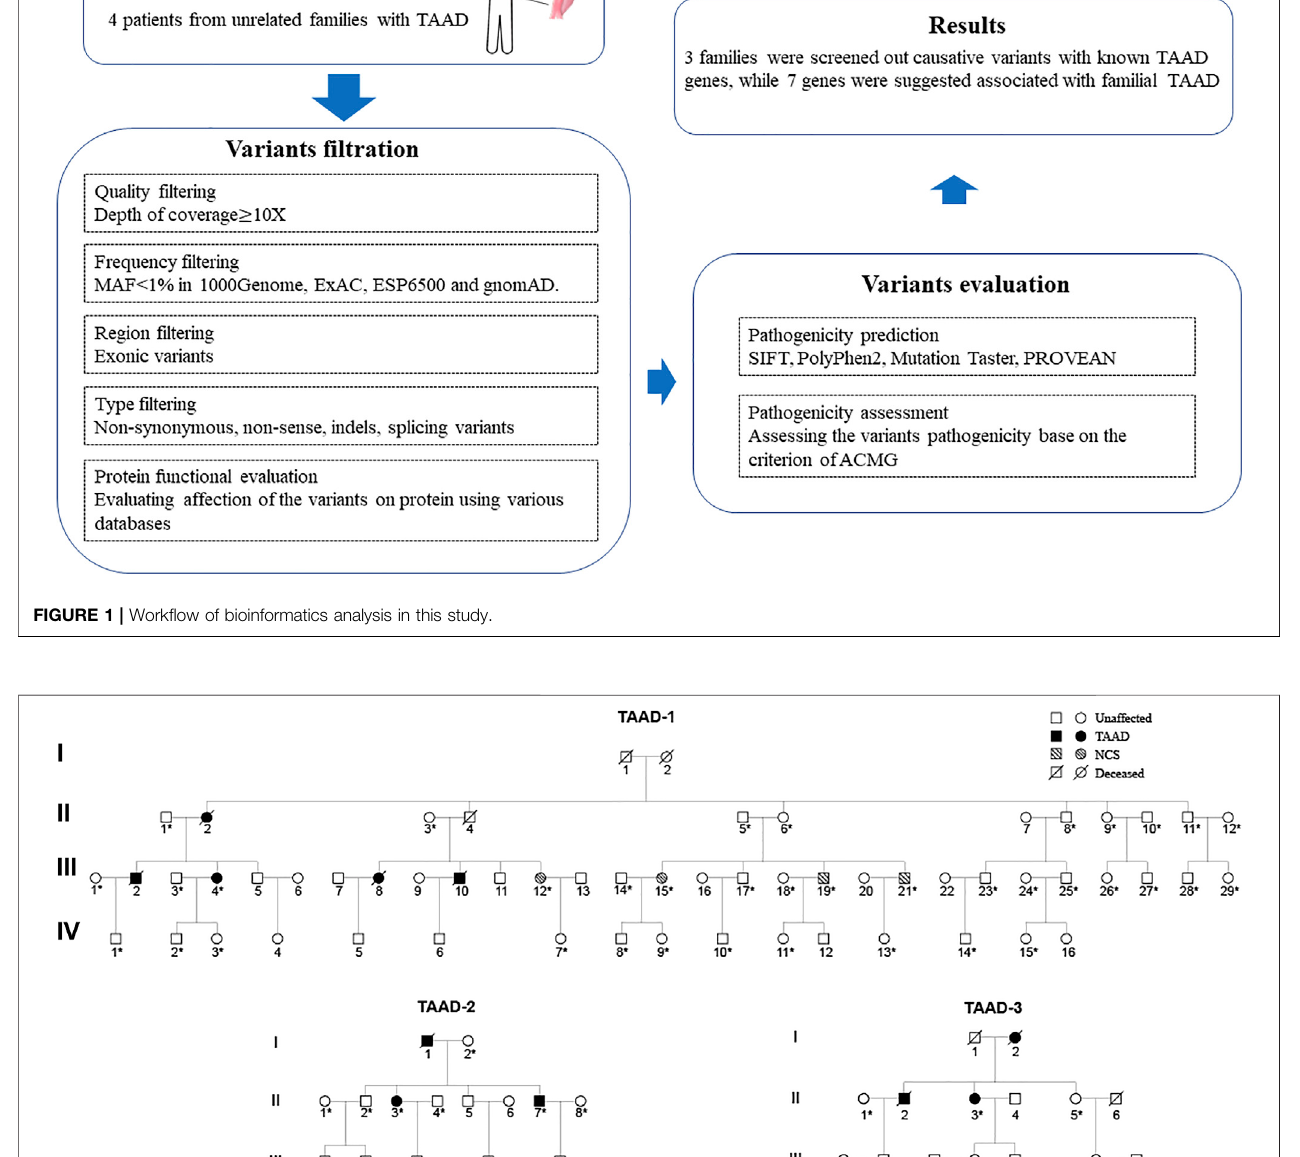
Frontiers in Genetics |